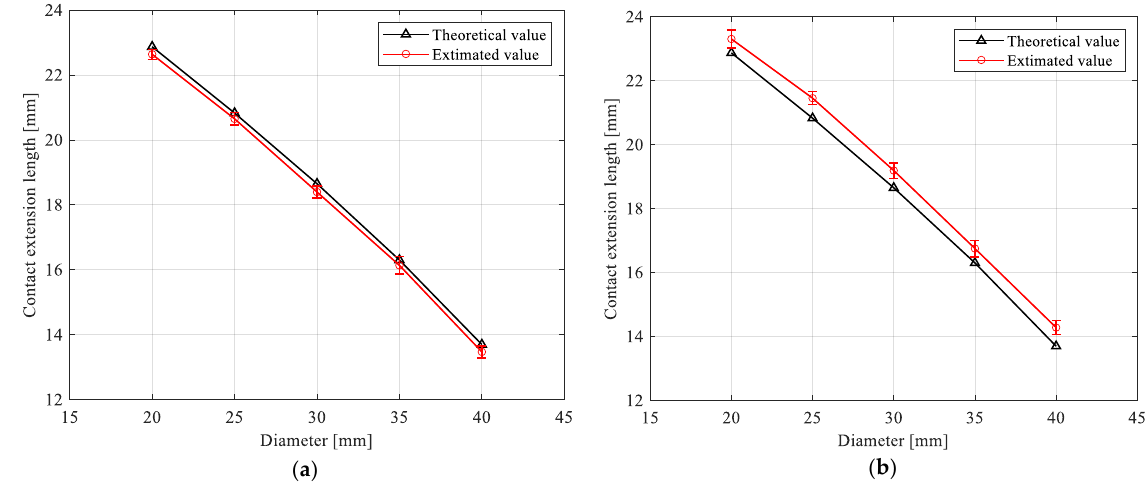
Figure 9. Estimation of contact extension length of the gripper. ( a ) Estimating contact extension length of gripper gripping rigid cylindrical objects, and ( b ) estimating contact extension length of gripper gripping soft cylindrical objects.